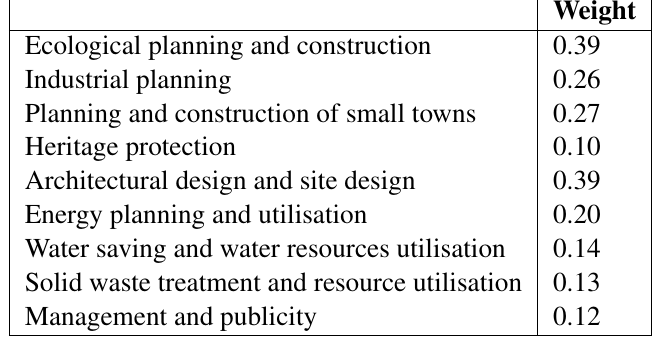
Table 1 Index weight table of evaluation standards for green small